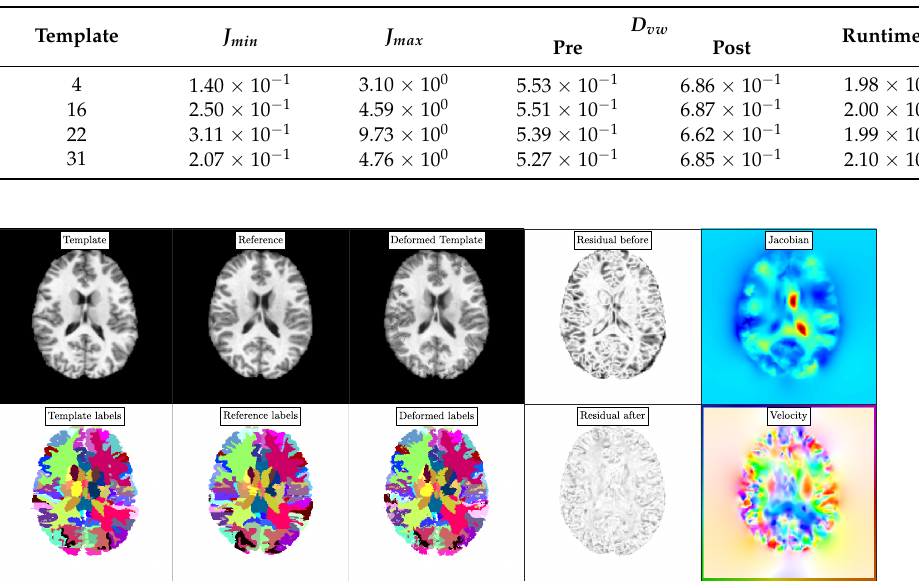
Figure 2. Experiment 1: Exemplary registration results using the parameter search scheme imple- mented in CLAIRE . We consider the datasets Template16 (template image) and Template27 (reference image). We refer to Table 3 and the text for details about the setup. We show (from left to right) the template, reference, deformed template image ( top row ), and their corresponding labels ( bottom row ). We also visualize the residual before and after the registration along with the determinant of the deformation gradient and an orientation map for the velocity